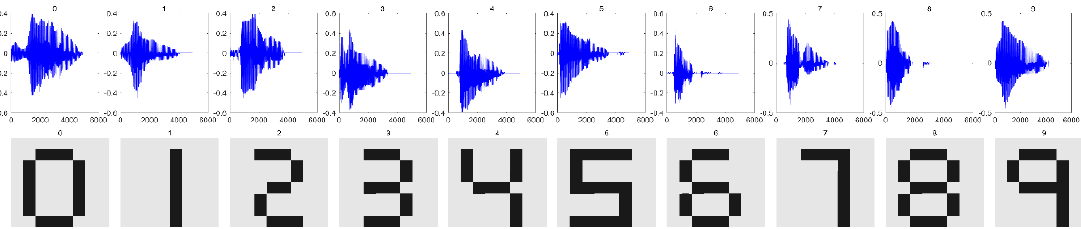
Figure 5. The noise-free auditory and visual stimuli used in the experiments.